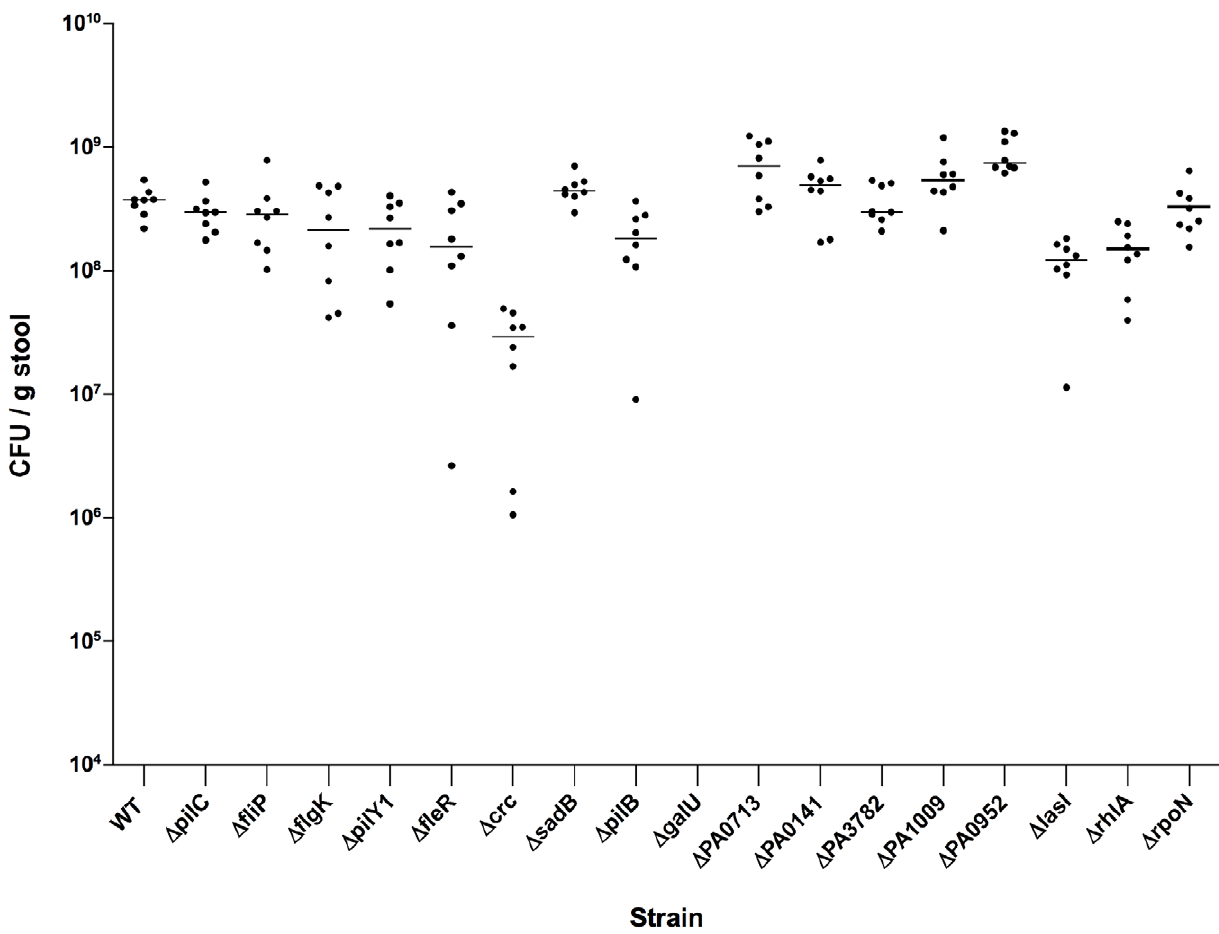
Figure 4. Gastrointestinal Colonization Levels Mice fed P.aeruginosa strains PA14 and the above listed PA14 transposon insertion mutants. Points represent result from individual animals (female 6–8 wk-old C3H/HeN mice), and horizontal lines represent the medians. n=8 for each strain. Colonization levels with strain D crc were significantly lower (p , 0.05 by Kruskal Wallis with Dunn’s multiple comparison test) compared with wild-type strain PA14